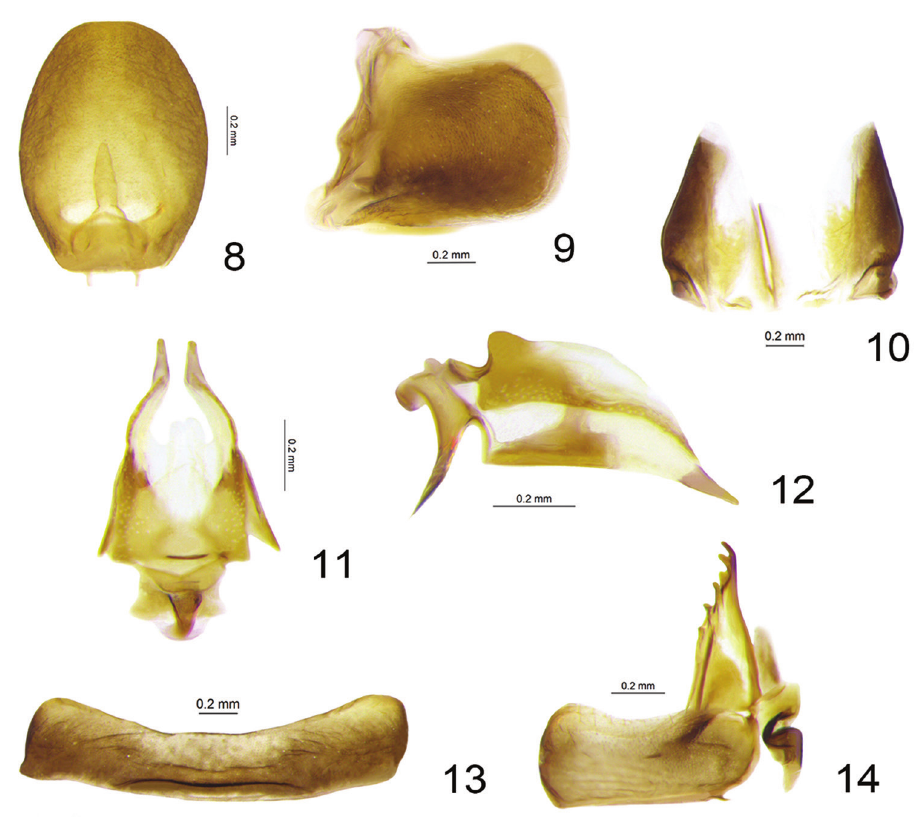
Figures 8–14. Sinonissus brunetus sp. n., paratype. 8 Female anal tube, dorsal view 9 Gonoplacs, lateral view 10 Gonoplacs, dorsal view 11 Gonapophysis IX and gonaspiculum bridge, dorsal view 12 Gona- pophysis IX and gonaspiculum bridge, lateral view 13 Sternite VII 14 Gonocoxa VIII and gonapophysis VIII, lateral